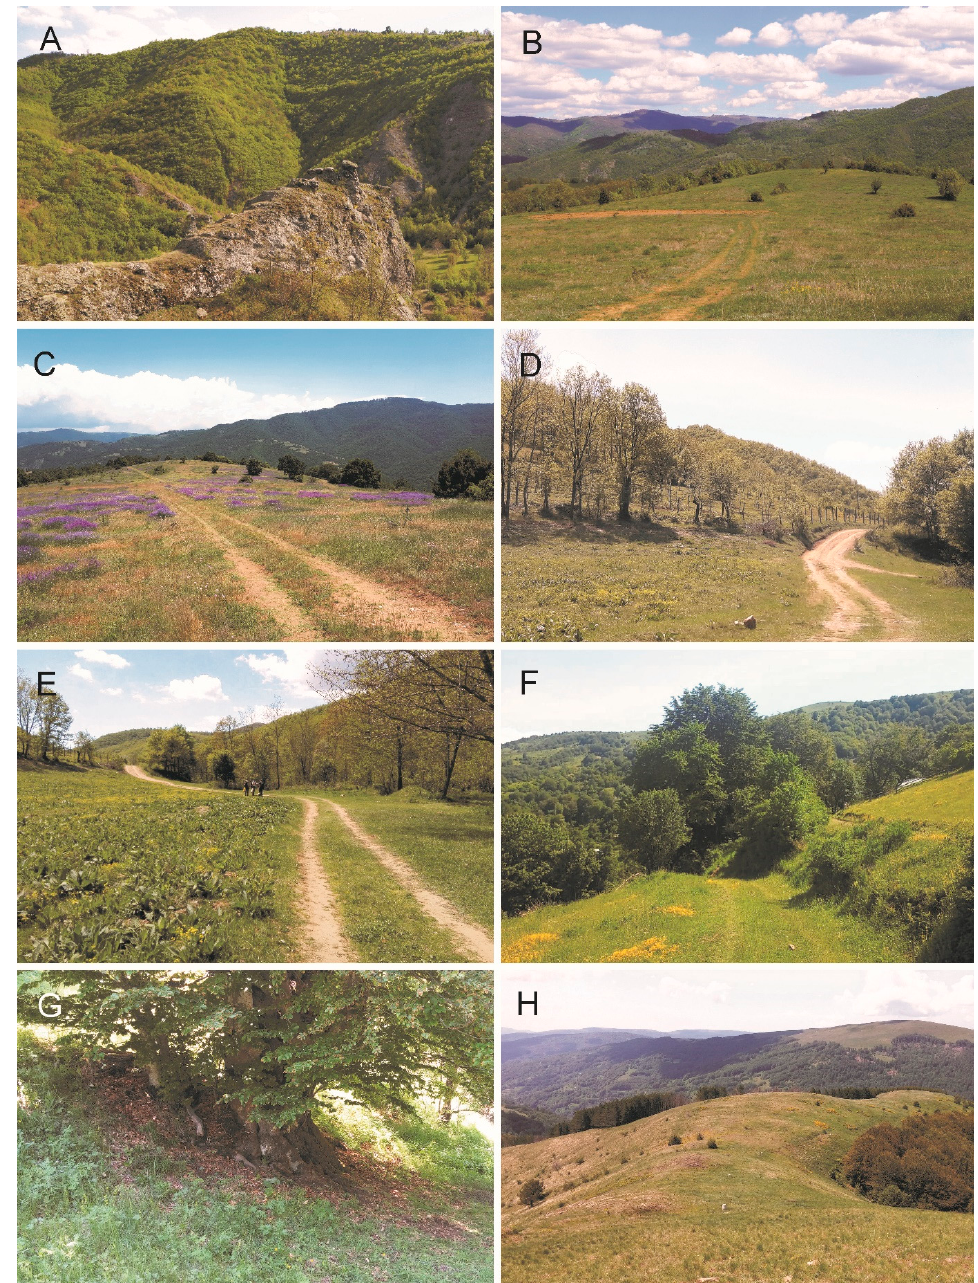
Figure 4. Collection localities of the scarabaeoid beetles in Serbia (2013, 2017–2019, 2021, 2022): ( A )—Donja Trnica at Trgovište, ( B , C )—Starac at Bujanovac (1), ( D , E )—Starac at Bujanovac (2), ( F , G )—Prolesje at Trgovište, ( H )—Crnoštica at Bosilegrad (Photos: ( A , B , D )—Dawid Marczak, ( C )—Adam Byk, ( E )—Rados ł aw Mroczy ń ski, ( F )—Marek Bidas and ( G , H )—Tomasz Gazurek).